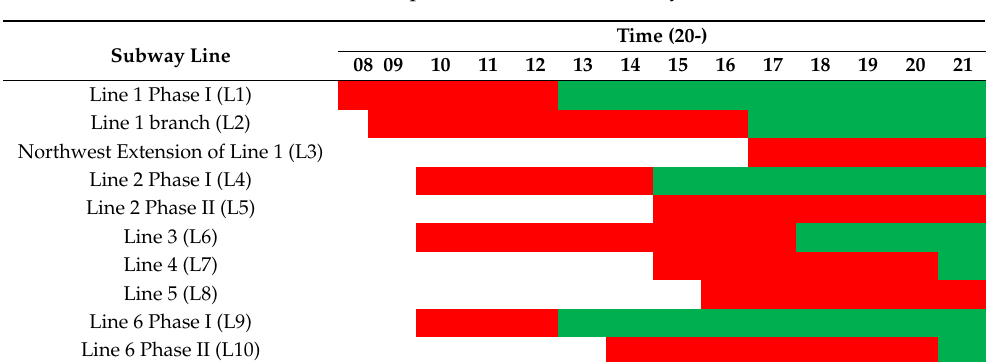
Figure 10. Analysis of urban construction on surface deformation: ( a ) is the superimposition of the results of the large-scale commercial districts and high-rise building data on a Google image, with a partial, enlarged view; ( b ) is the superimposition of the results of the large-scale commercial district and high-rise building data and the settlement rate; ( c ) is the overlaid result plot of subway data and subsidence rate. Table 4. Timetable for construction and operation of various subway